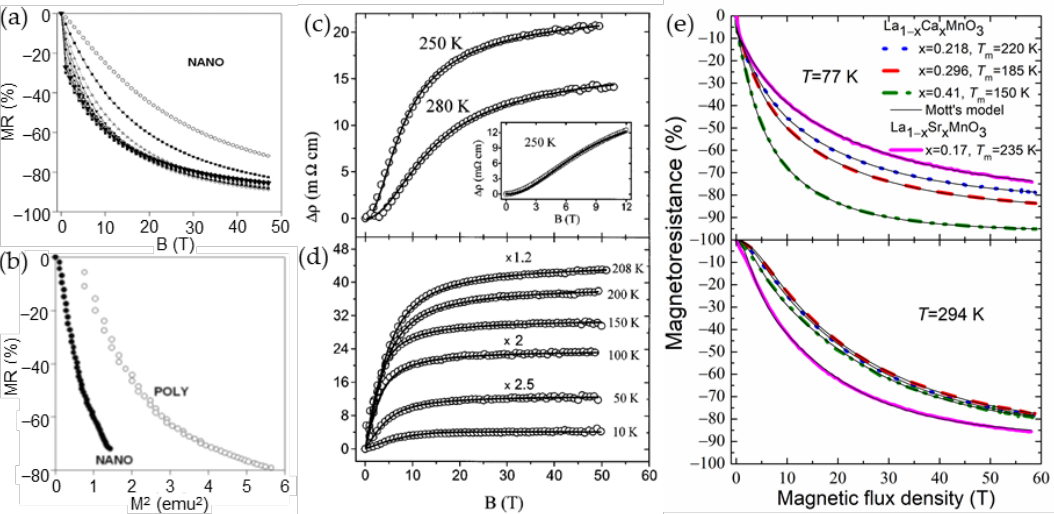
Figure 8. ( a ) Magnetic field dependences of magnetoresistance for nanocrystalline La 0.8 Sr 0.2 MnO 3 manganites at temperatures 300, 260, 217, 187, 157, 130, 74, 62, 41, 29, 19, 10, 6.4, 4.2, and 1.7 K (from top to bottom); ( b ) the magnetoresistance as a function of a square of magnetization at 300K for the poly- and nanocrystalline La 0.8 Sr 0.2 MnO 3 manganites. Reprinted with permission from [54]. Copyright 2015 AIP Publishing; ( c ) magnetic field dependence measured in the pulsed field of the resistivity decrease in the paramagnetic (PM) phase. A thin solid line shows fitting by the square of the Brillouin function. The inset presents measurements in a superconducting magnet; ( d ) the resistivity decrease in the magnetic field fitted by the Brillouin function in the ferromagnetic (FM) regime. Curves at several temperatures are multiplied with the indicated figures for better clarity. Reprinted with permission [61], © 1998 American Physical Society; and ( e ) MR vs. magnetic flux density de- pendences in the FM (77 K) and PM (294 K) phases of nanostructured La 0.83 Sr 0.17 MnO 3 and La 1-x Ca x- Mn y O 3 films having different composition x . Thin solid curves represent fitting results to the modi- fied Mott’s VRH model taking into account contributions of crystallites and grain boundaries: upper panel — fitting by the Brillouin function using Equation (2) at 77 K, lower panel — fitting by square of the Brillouin function using Equation (3) at 294 K. Reprinted with permission from [75]. Copy- right 2014 IEEE.